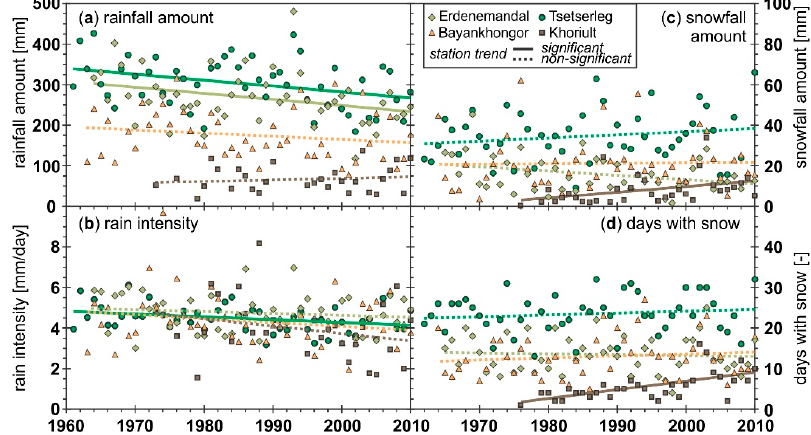
Figure 2. Time series and trends for water year (1 October to 30 September) ( a ) rainfall amounts; ( b ) rainfall intensity; ( c ) snowfall amounts; and ( d ) days with snow at the four study stations from 1961 to 2010.